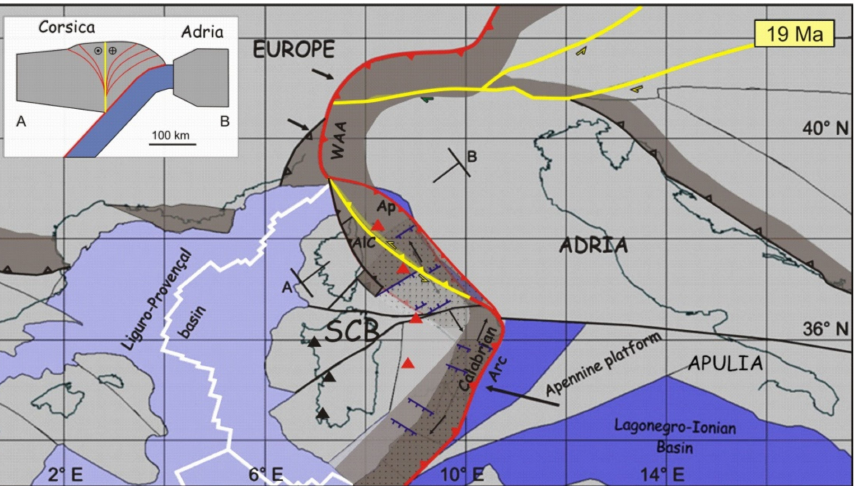
Figure 3. Plate reconstruction of the western Mediterranean region at 19 Ma (late Aquitanian). Dotted areas indicate wedge-top basins. Lower Miocene Chains are shown in ( dark gray ), the Africa-Adria continental lithosphere is in ( light gray ), the oceanic crust is in ( blue ). ( Red lines ) are active boundaries. ( Black lines ) are inactive boundaries. ( Yellow lines ) are strike-slip faults. ( Red triangles ) are volcanoes associated to the Tethys subduction; ( black triangles ) are volcanoes probably associated with the pyrenaic subduction. AlC: Alpine Corsica; Ap: proto-Apennine chain; SCB: Sardinian-Corsican block; WAA: Western Alpine Arc. Other symbols are the same from Figure 2; modified after